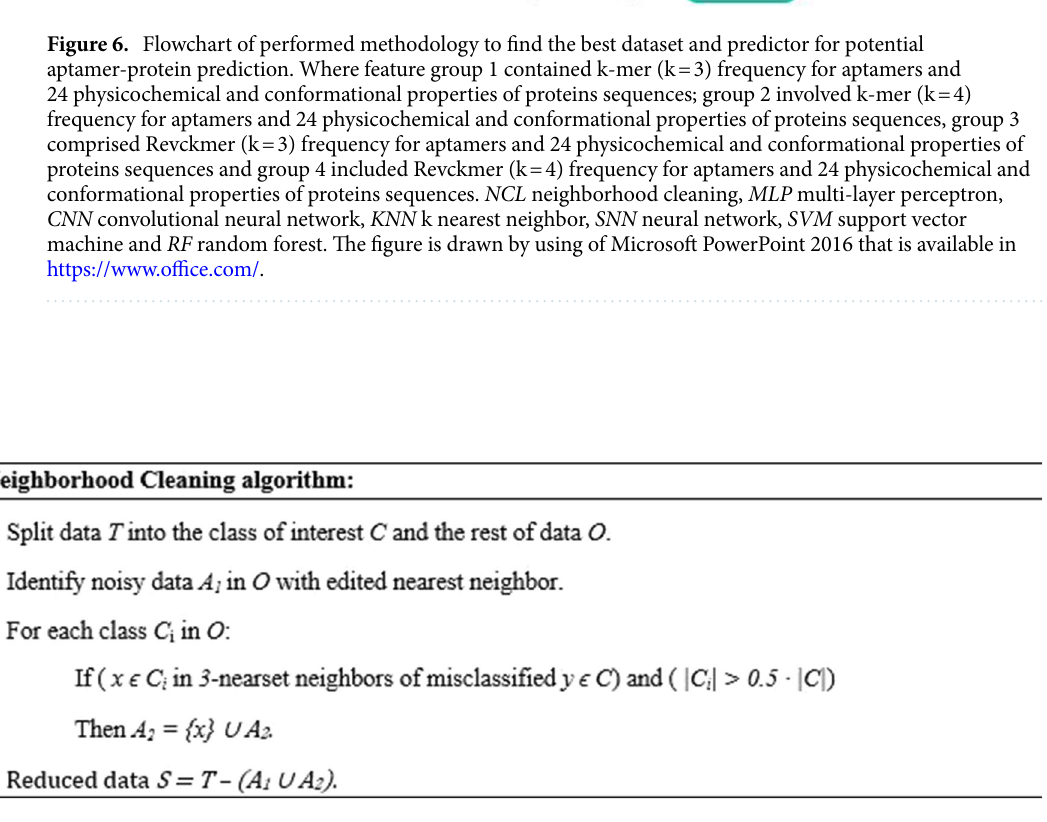
Figure 7. The Neighborhood Cleaning Algorithm. The figure is drawn by using of Microsoft PowerPoint 2016 that is available in https ://www.offic